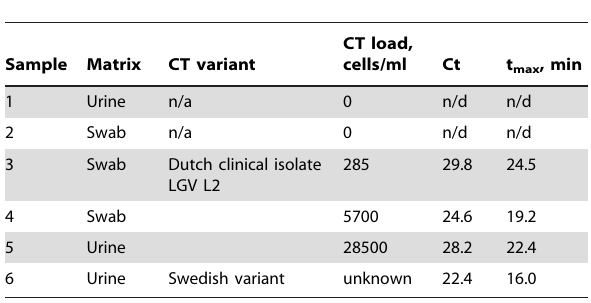
Table 2. Summary of the samples used in the comparison of ChAT LAMP-BART with TaqMan PCR (n/a: not applicable. n/d: not